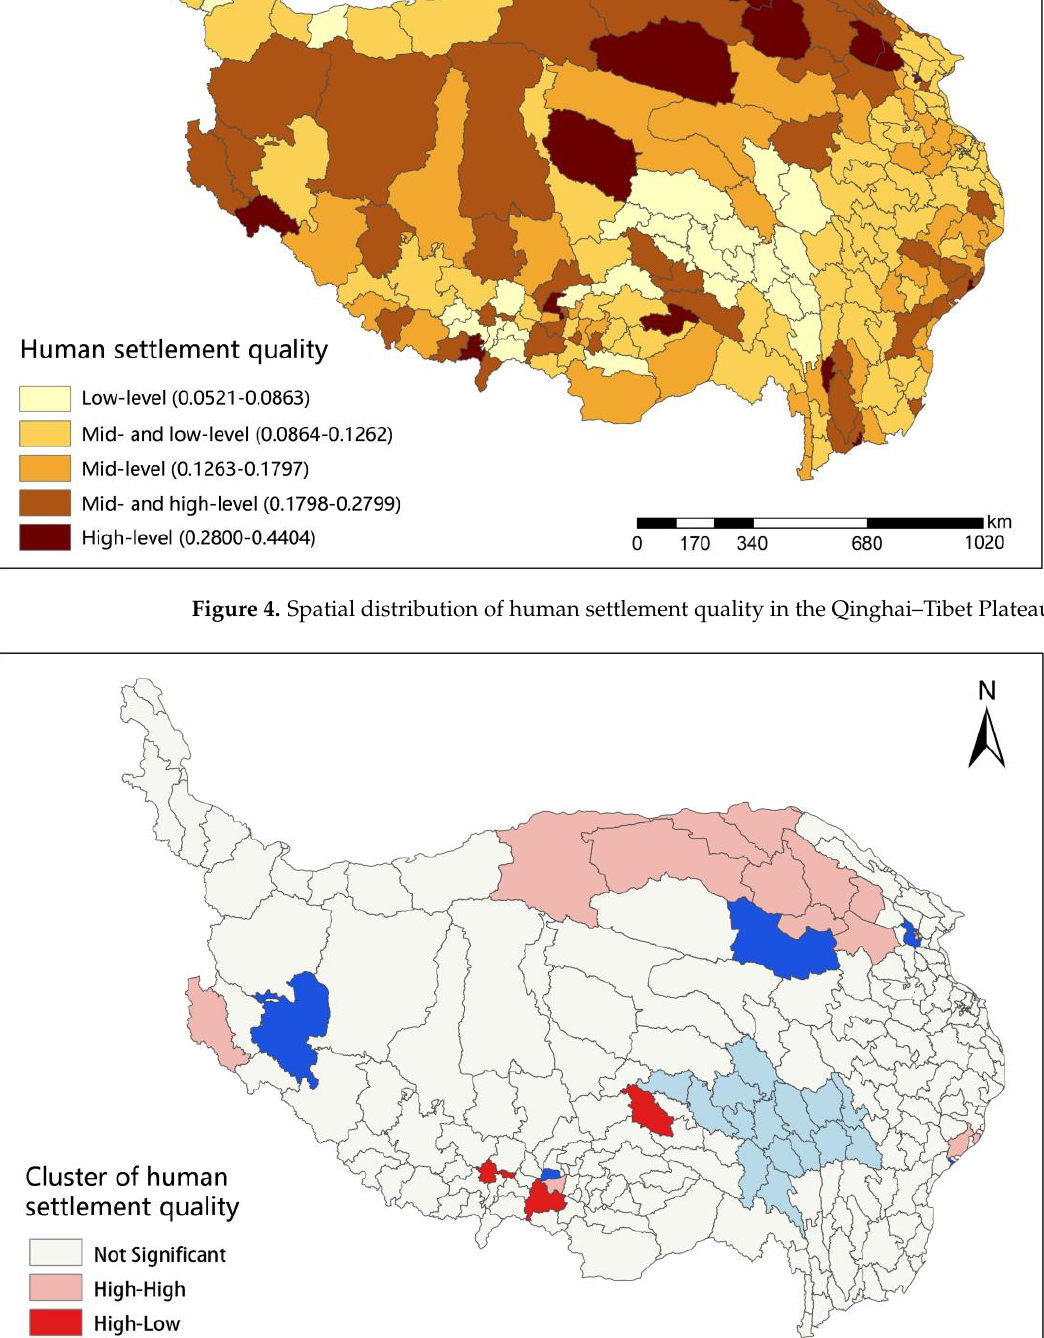
Figure 5. Cluster distribution of human settlement quality in the Qinghai–Tibet Plateau.